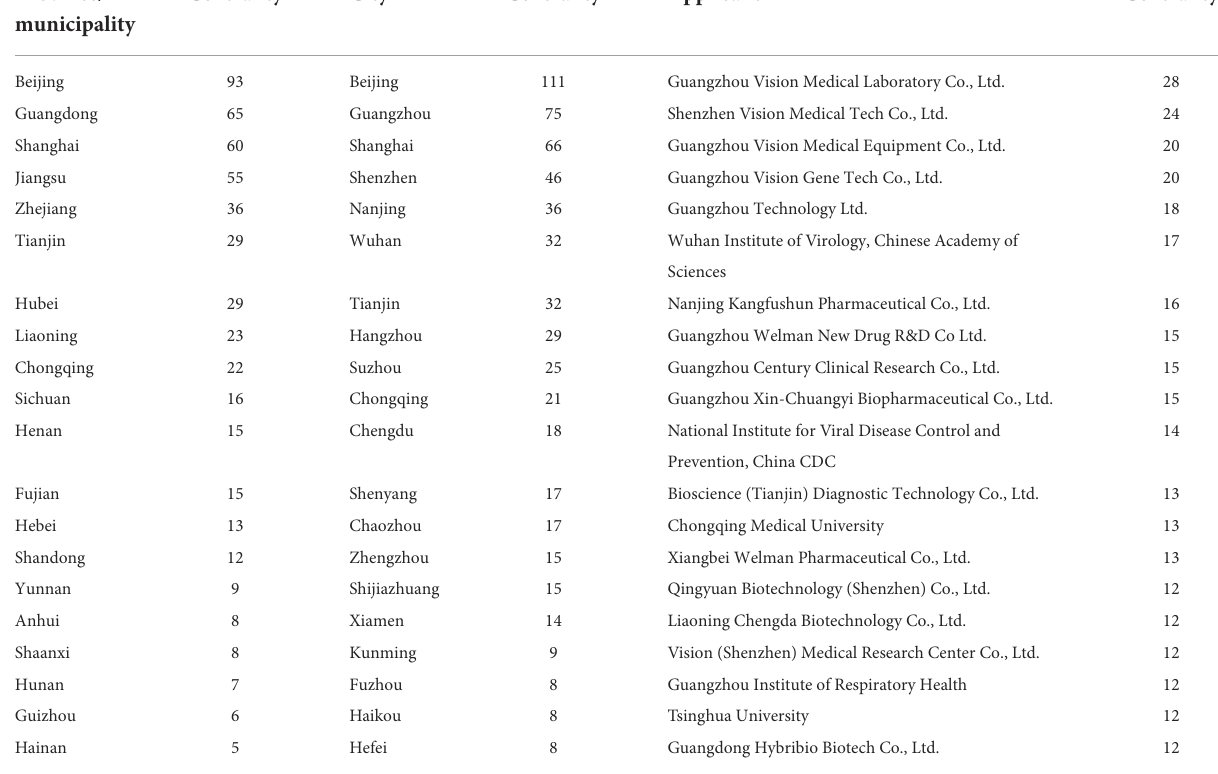
TABLE 2 Centrality of top 20 nodes in the COVID-19 patent cooperation